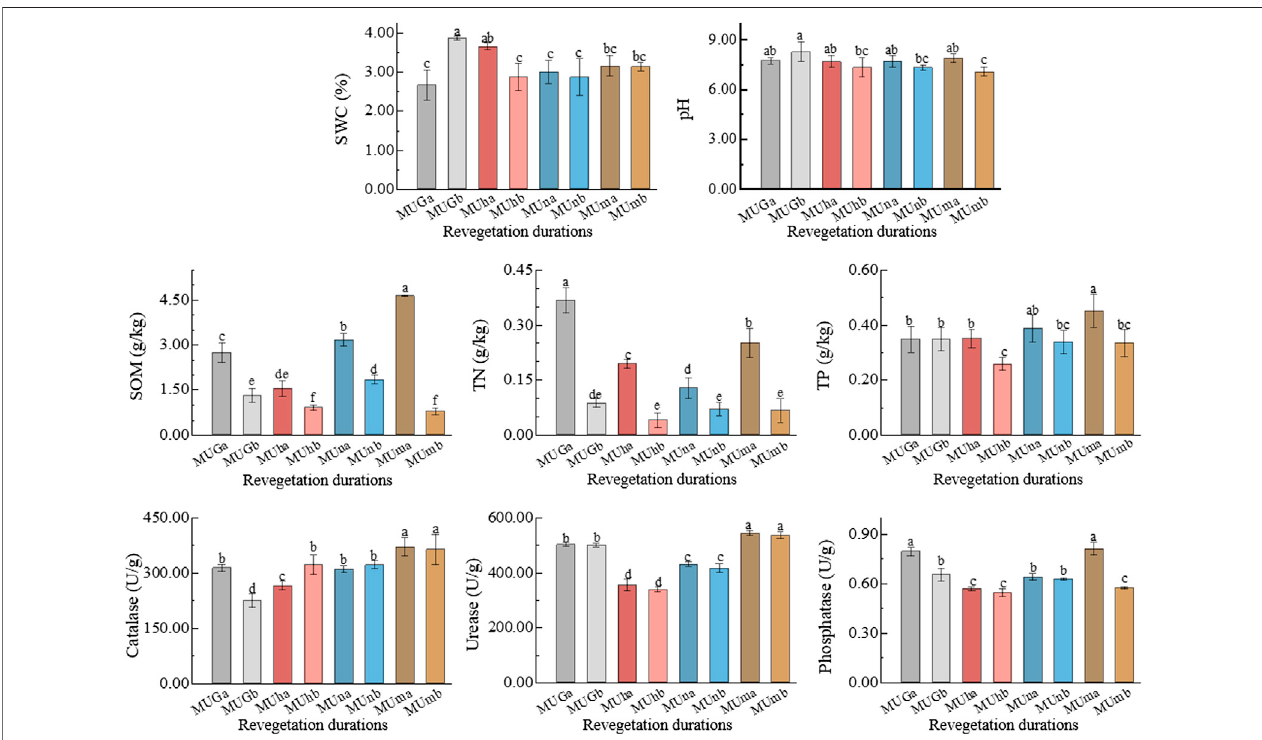
FIGURE 1 | Soil properties in different soil depths trough revegetation durations. Different letters are signi fi cantly different ( p < 0.05).